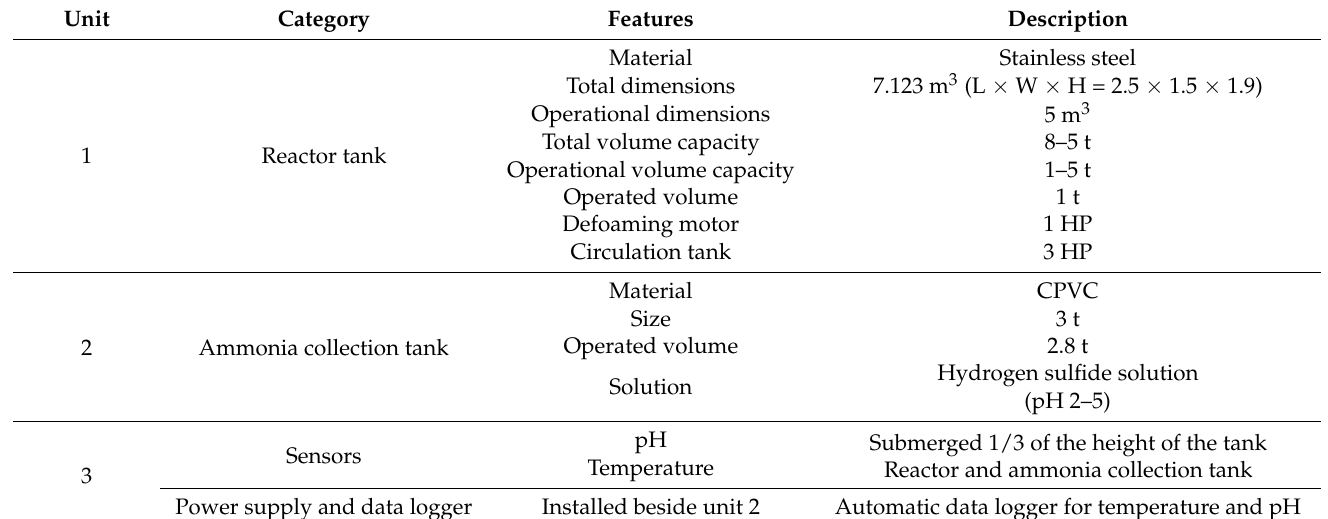
Figure 1. Field-scale TAO reactor ( a ) diagram and ( b ) the equipment. In the diagram, (1) main reactor tank, (2) looking glass, (3) hatch, (4) influent inlet pipeline, (5) ejector-type aeration pump, (6) manure circulation pipeline, (7) foam cutting motor, (8) foam cutting fan, (9) air circulation pipeline, (10) NH 3 -N gas transfer pipeline, (11) NH 3 -N trapping tank, (12) NH 3 -N tank pH and temperature sensor, (13) tank supporting platform, (14) hot water supply tank, (15) control box, and (16) reactor pH and temperature sensor. Table 2. Description of the TAO system.